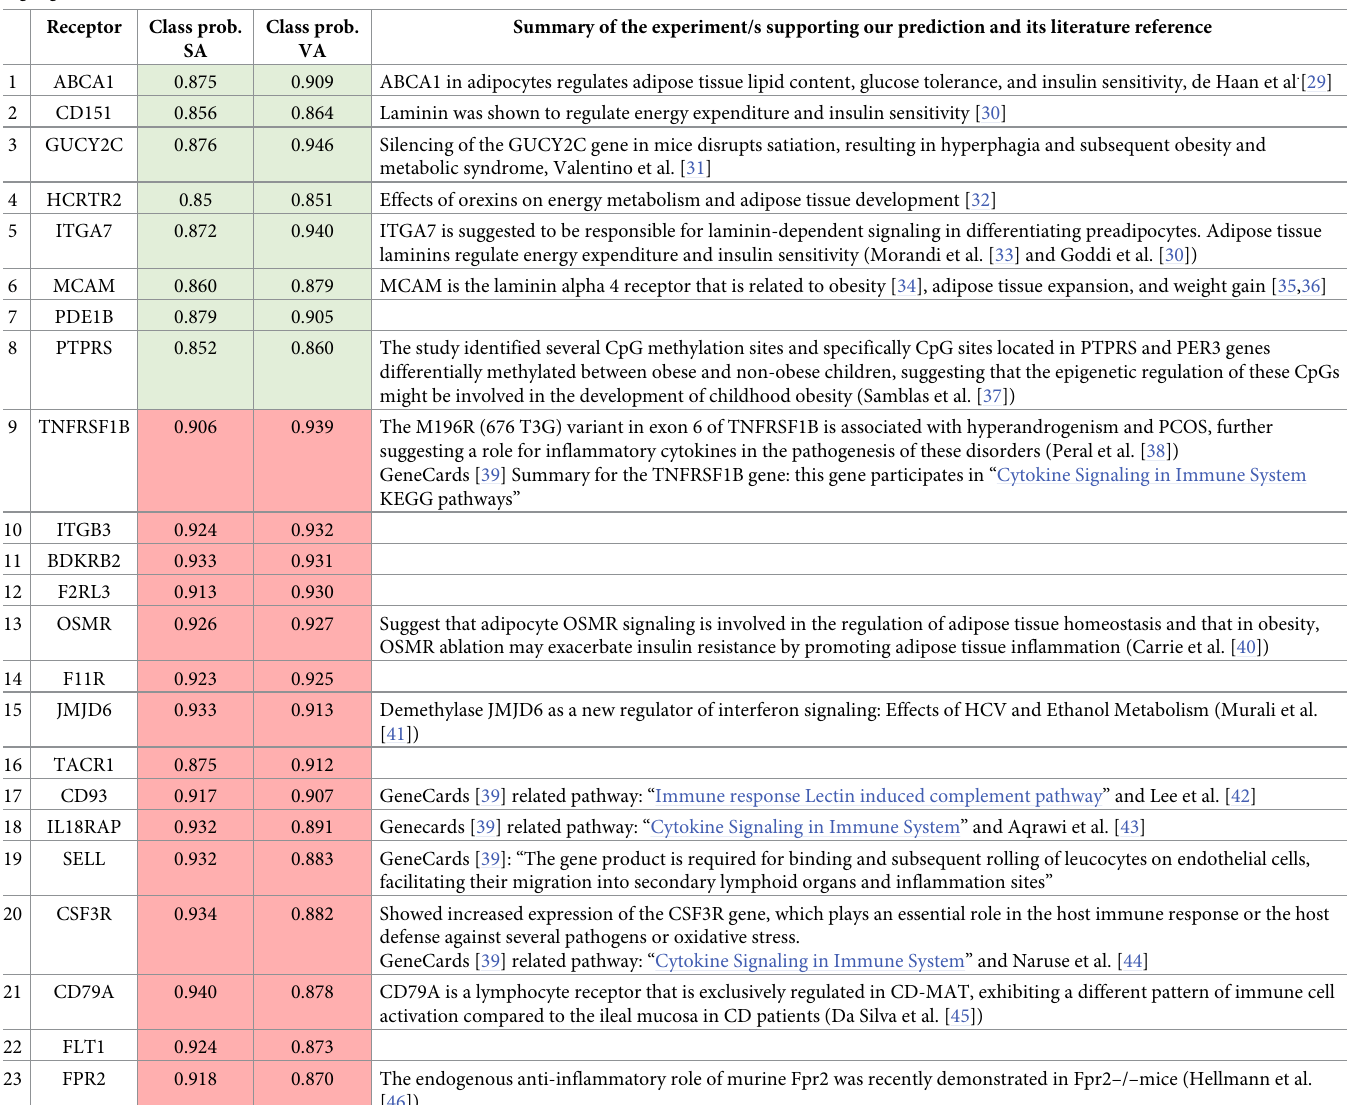
Table 3. Receptors with unknown metabolic and inflammatory functions, which we predicted to have similar functions in both subcutaneous and visceral adipose tissues, and references supporting our predictions. Eight first receptors predicted to be “metabolic” are highlighted in light green and 15 “inflammatory” receptors are highlighted in